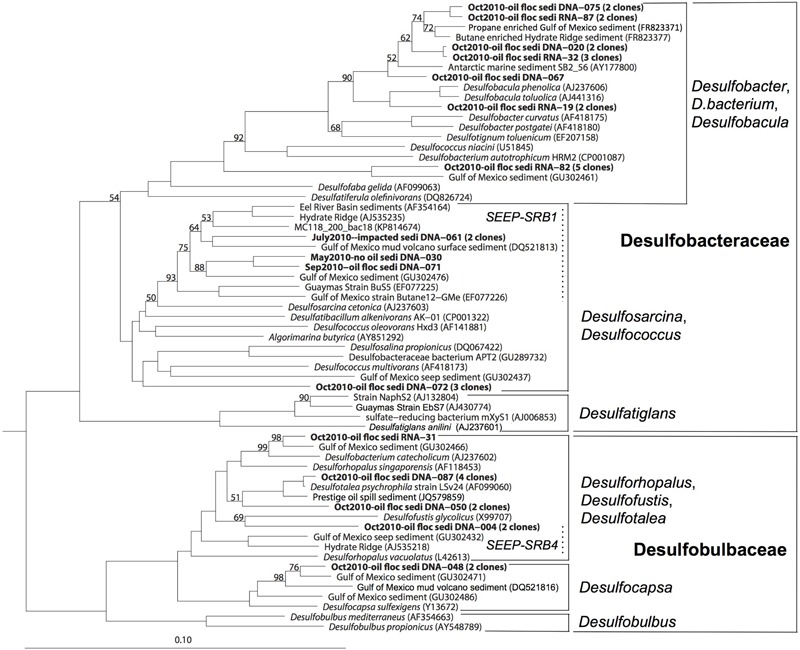
16S rRNA gene phylogenetic tree of the deltaproteobacterial families Desulfobacteraceae and Desulfobulbaceae. The scale bar corresponds to 10% sequence distance (Jukes-Cantor). The phylogeny was rooted with the Gammaproteobacterium Colwellia psychrerythraea.